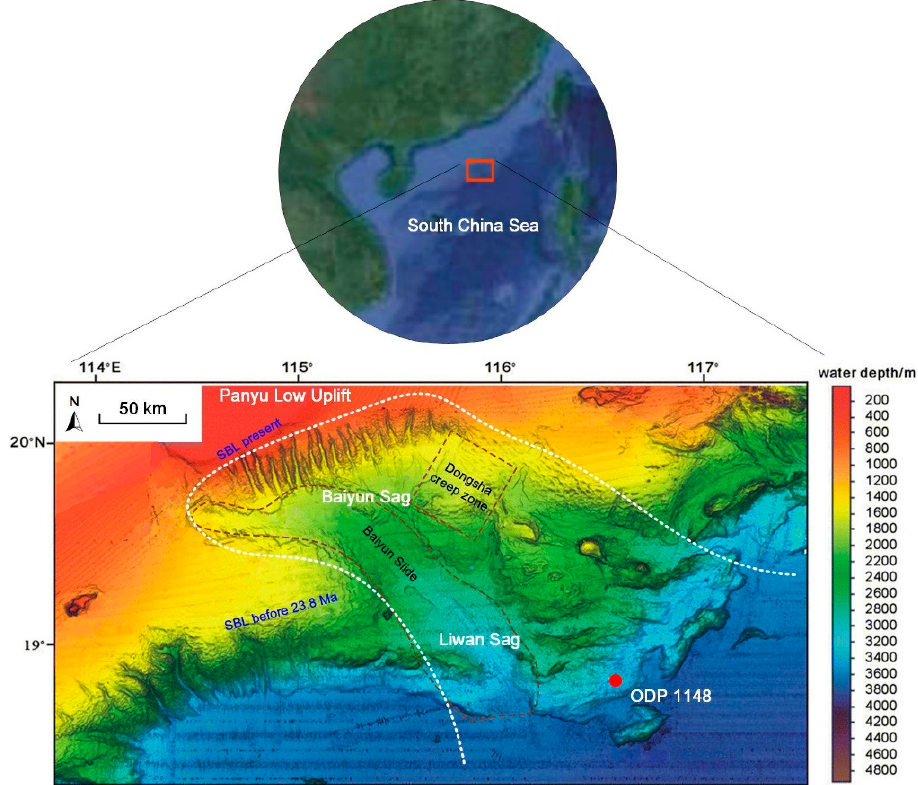
Figure 1. Multi-beam submarine geomorphology shadow map showing the Baiyun–Liwan submarine slide, the Baiyun slide, the Dongsha creep zone, and the shelf break line (SBL). The white dotted line is a scarp of the Baiyun–Liwan submarine slide. The brown dotted lines are the scarp of the Baiyun slide and range of the Dongsha creep zone, respectively.